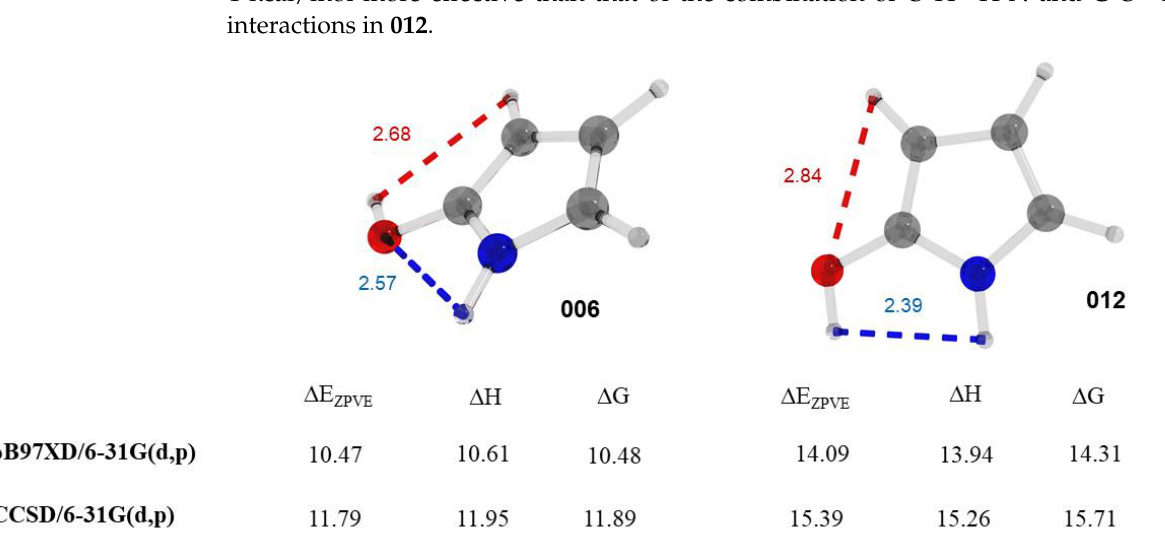
Figure 2. Optimized structures of the enols 006 and 012 (CCSD/6-31G(d,p)), important interatomic distances (Å) and their relative thermodynamic parameters (kcal/mol). Hydrogen: light grey, Carbon: black, Nitrogen: blue, Oxygen: red.